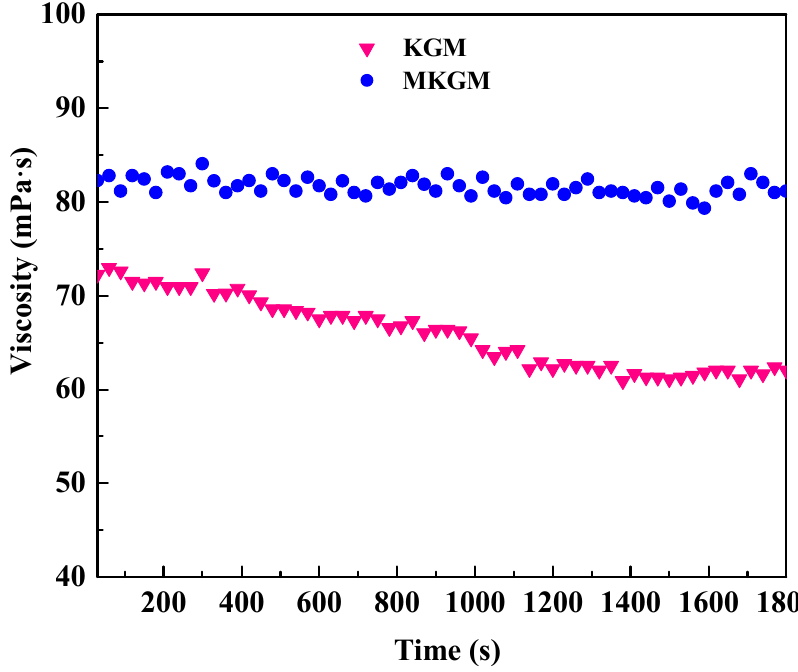
Figure 7. The shear resistance performances of KGM and MKGM gels.